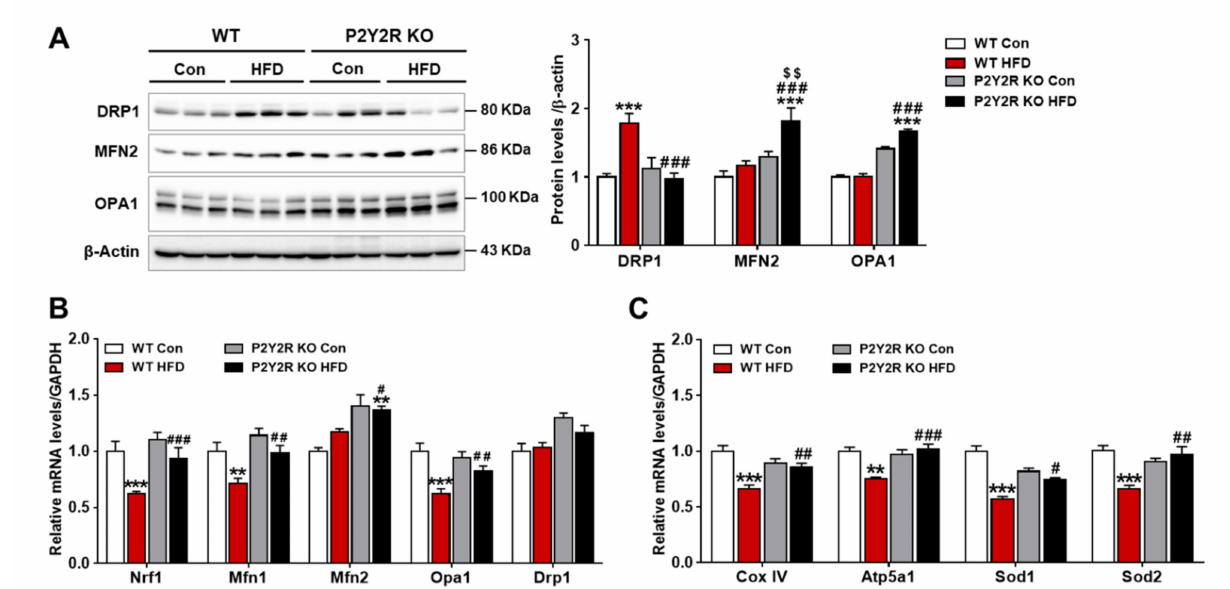
Figure 5. P2Y2R deficiency attenuates hepatic mitochondrial dysfunction in HFD-fed mice. ( A ) Liver tissues were lysed to perform western blot analysis, and the protein levels of DRP1, MFN2, OPA1 and β -actin (a loading control) were examined. Quantitative analysis of each protein was shown ( n = 5). ( B , C ) The mRNA expression of genes involved in mitochondrial dynamics and respiratory and antioxidant functions was determined by real-time PCR analysis. Relative mRNA levels were normalized to those of GAPDH ( n = 3–5). Data are presented as the mean ± SEM. One-way ANOVA was used for statistical analysis followed by Bonferroni’s multiple comparison test. ** p < 0.01, *** p < 0.001 vs. WT control mice; and